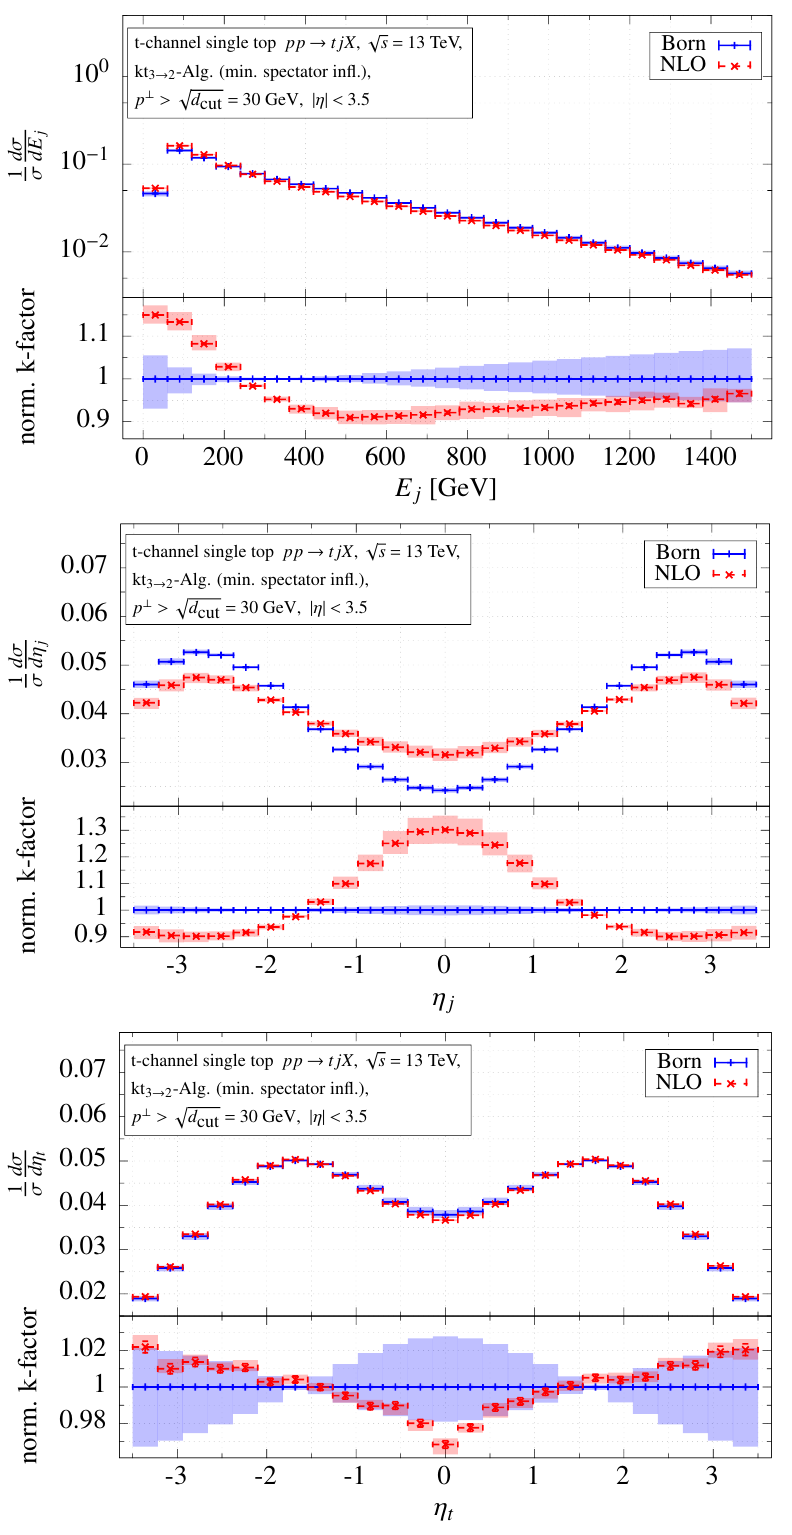
Figure 12 . Same as (cid:12)gure 10 but for the inclusive event de(cid:12)nition.